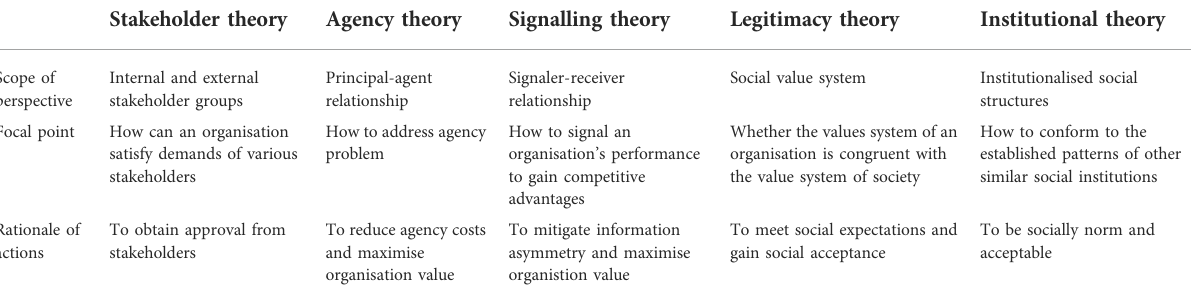
TABLE 2 The dissimilarities among